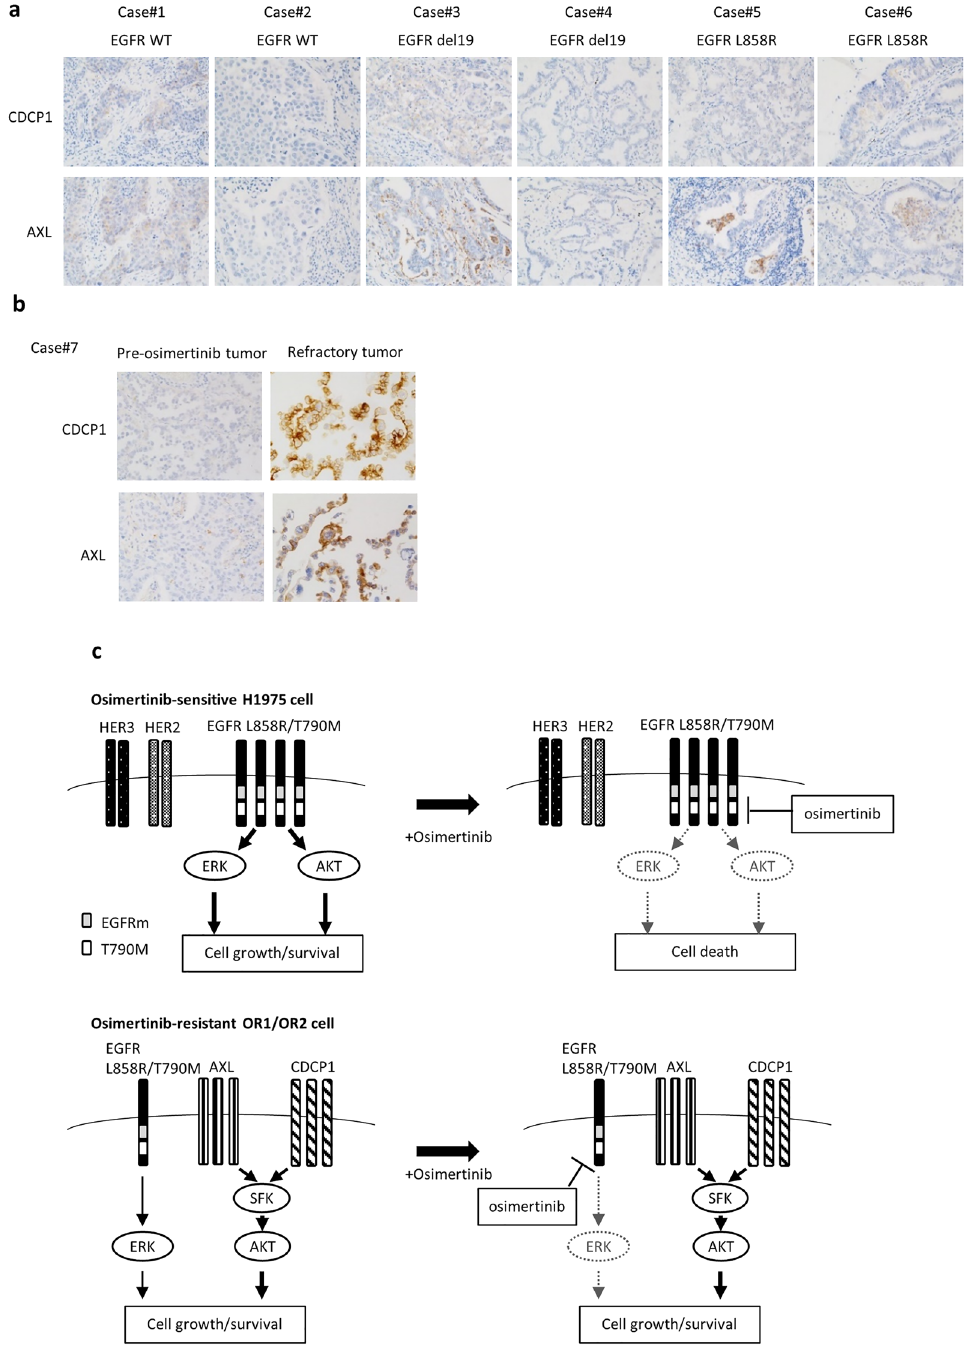
Figure 6. Expression of AXL and CDCP1 in lung tumors of patients. ( a ) IHC analysis of AXL or CDCP1 expression in surgically resected tumors of 6 patients (cases #1–6) before chemotherapy. ( b ) IHC analysis of AXL and CDCP1 in tumors before EGFR TKI treatment and after recurrence (cases #7). ( c ) Hypothetical model of how osimertinib resistance is acquired. In osimertinib-sensitive cells, the PI3K/AKT pathway driven by EGFR harboring mutEGFR and T790M is highly susceptible to osimertinib. By contrast, in osimertinib resistant cells, expression of the driver EGFR is reduced, accompanied by SRC activation together with enhanced expression of AXL and CDCP1. Enhanced expression of AXL and CDCP1 activates SFK and AKT signaling pathway, resulting in promotion of cell growth and